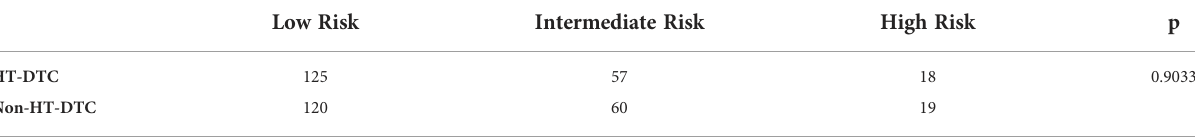
DTC, Differentiated Thyroid Cancer; HT, Hashimoto